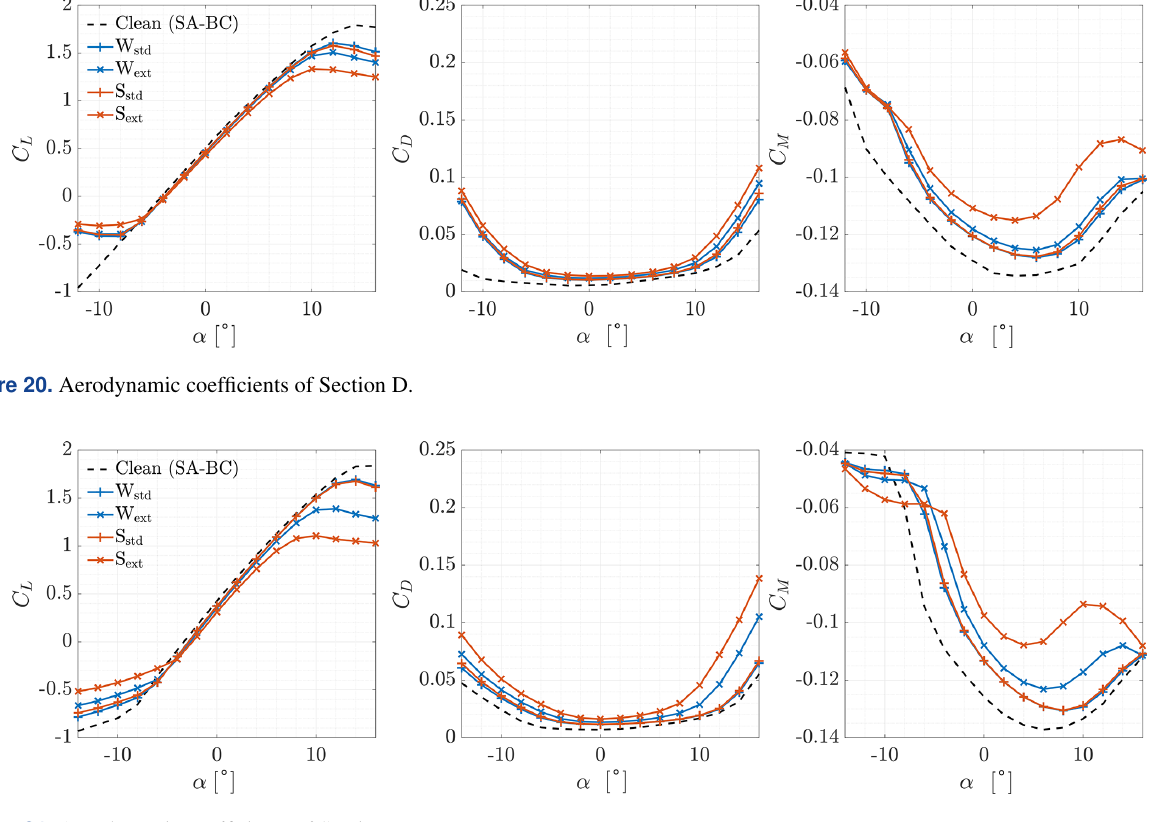
Figure 21. Aerodynamic coefficients of Section E.